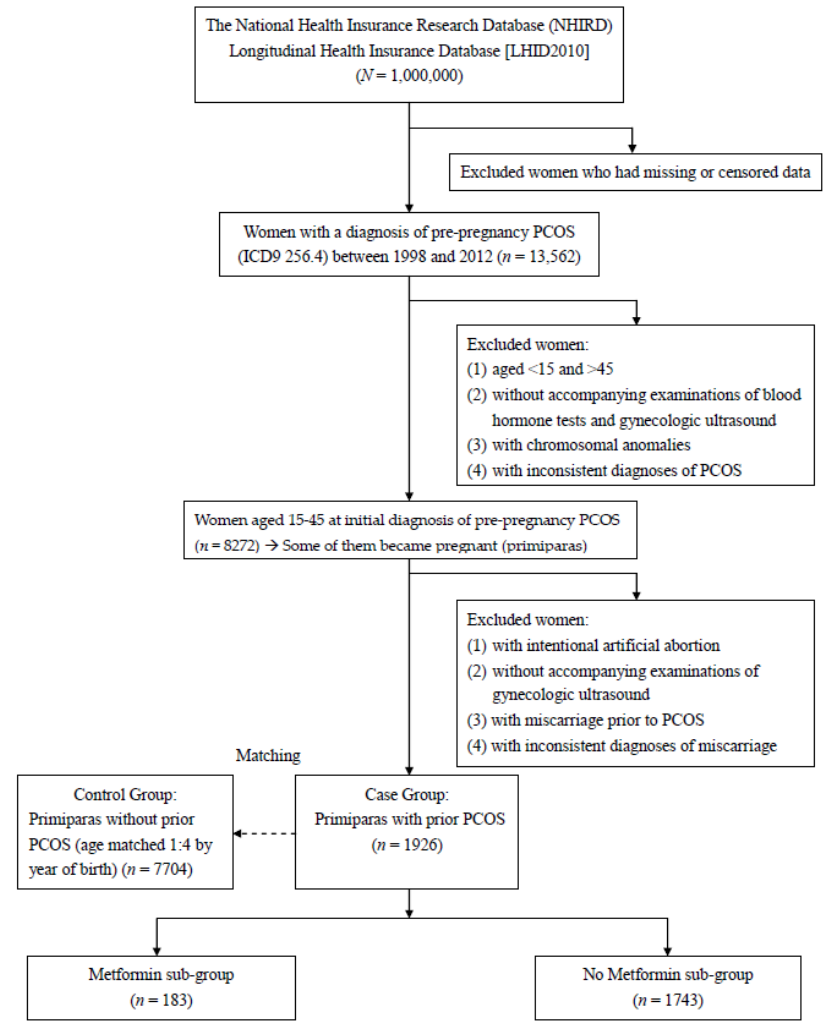
Figure 2. The flowchart of case inclusion, exclusion, and classification for the women with/without pre-pregnancy PCOS.